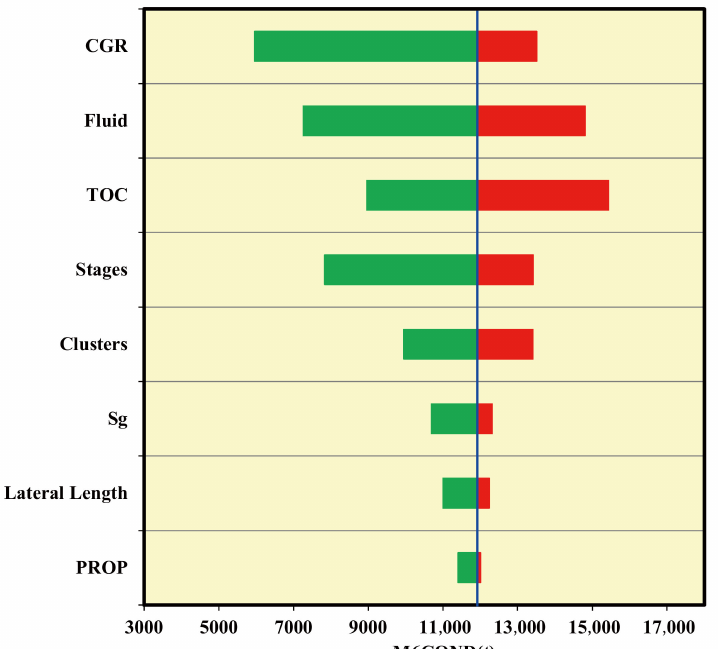
Figure 7. Tornado plot illustrating the most and the least important factors for M6COND. Each red bar equals to a sensitivity measure (compared with a base example) when a factor is designed to its upper bound. The green bars indicate the lower-bound case. The blue line in the middle means the base case. Factors are arranged by descending order from top to